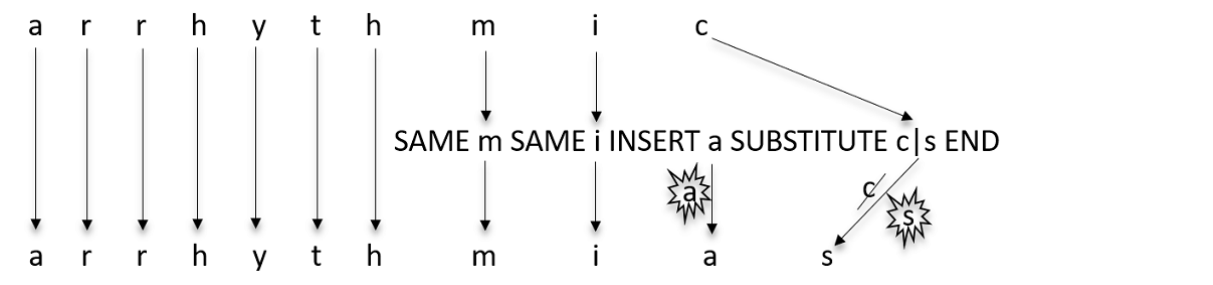
Figure 3. An illustration of how the edit pattern “SAME m SAME i INSERT a SUBSTITUTE c|s END” converts the clinical term “arrhythmic” to